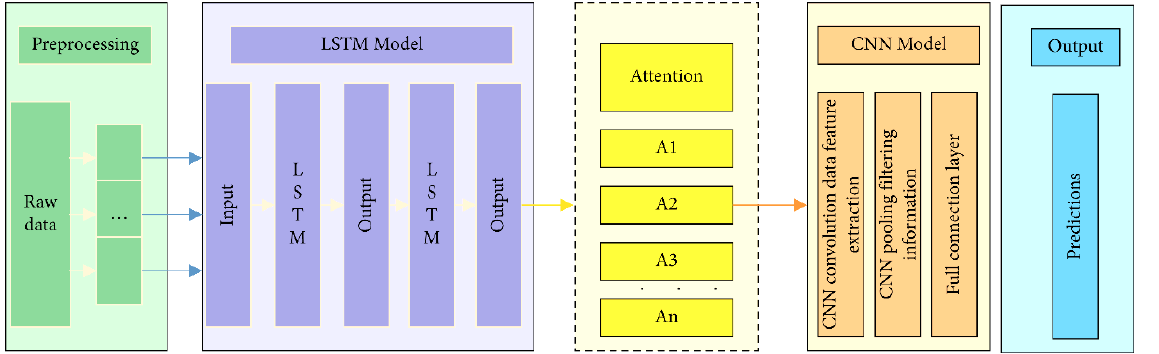
Figure 7. Fused attention mechanism based representation of flow of stages in the proposed CNN- LSTM